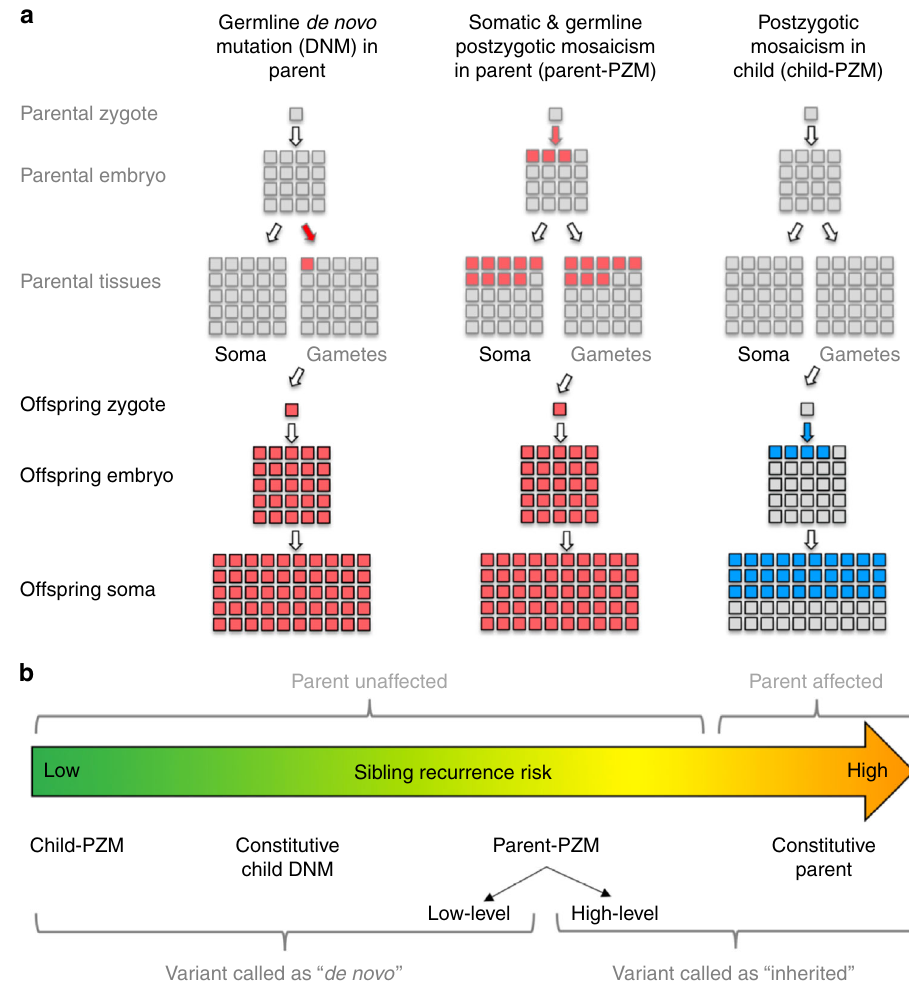
Fig. 1 Timing of de novo mutations. a De novo mutations (DNMs) can occur at any point prior or during development of the embryo, potentially resulting in mosaicism. The most common form of DNM (left) occurs in the parental gametes and is constitutive in the child. A postzygotic (PZM) DNM in the parent (middle) results in mosaicism across multiple parent tissues and a constitutively inherited variant in the child when the parental gametes are affected. A PZM DNM in the child (right) is not present in any parental tissue but is mosaic in the child. b Sibling recurrence risk varies with timing of PZM, from very low in child-PZM, to medium in parent-PZM, to high (50%) in affected parents with constitutive pathogenic variants. Different types of mosaic variants can be misclassi fi ed by standard variant callers, resulting in erroneous risk estimation or missed